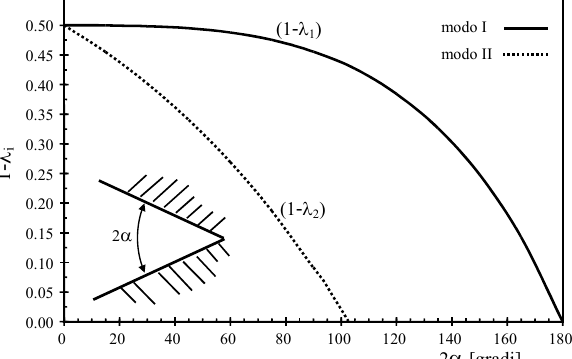
Figura 3. Grado di singolarità 1- λ dei campi di tensione in prossimità di intagli a V non raccordati in funzione dell’angolo di apertura.